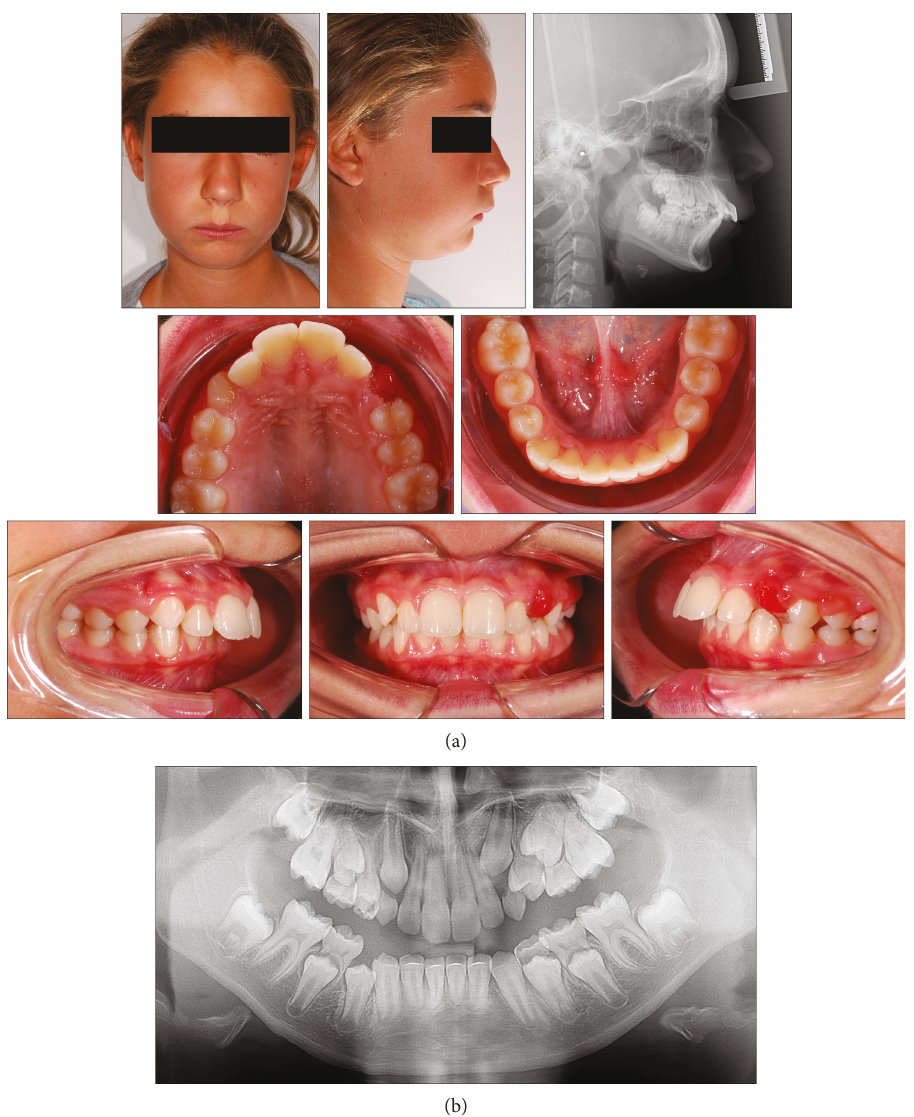
Figure 6: Case 2. (a) 9-year and 8-month-old female patient with skeletal Class II malocclusion, increased overjet, and overbite before treatment. (b) Panoramic radiograph taken at fi rst visit when the patients was 8 years 10 months